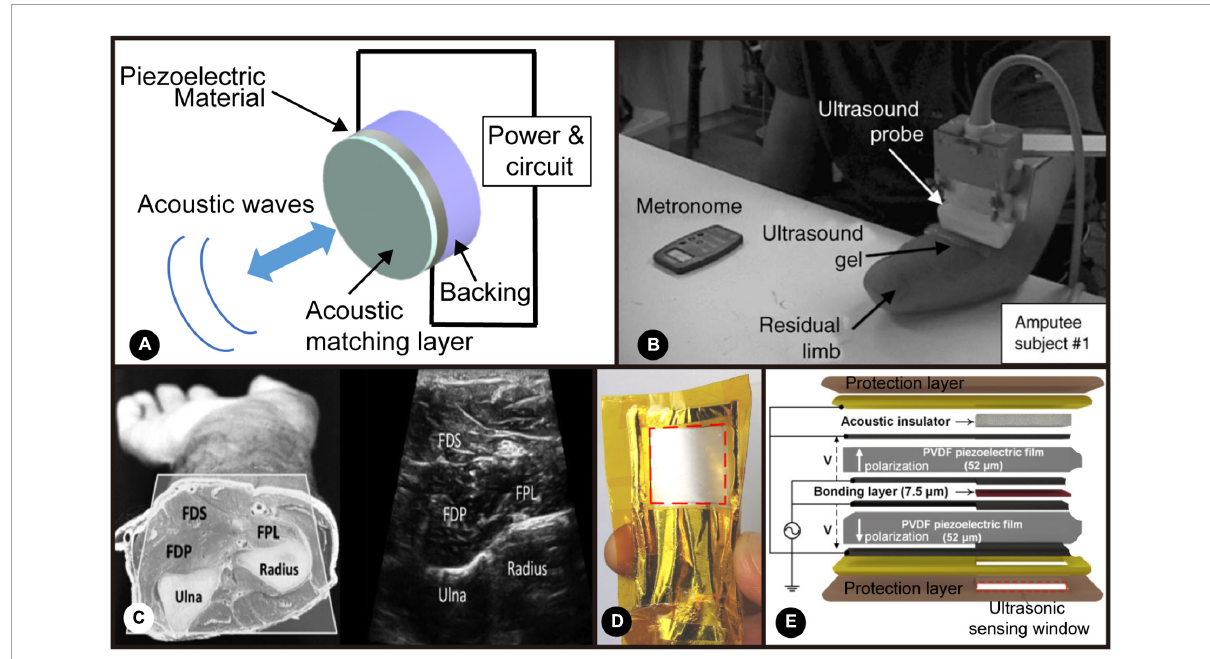
FIGURE6 (A) Schematic of an ultrasonic transducer. Adapted from Sanchez et al. (2021). Copyright 2021, IEEE; (B) Experimental set-up by Zheng et al. (2006). Reproduced with permission (Zheng et al., 2006). Copyright 2006, Elsevier; (C) the cross-section and ultrasound image of the forearm muscles by Akhlaghi et al. (2016). Adapted from Akhlaghi et al. (2016). Copyright 2016, IEEE; (D) the photo of wearable ultrasonic sensor developed by AlMohimeed and Ono (2020). Reproduced with permission (AlMohimeed and Ono, 2020). Copyright 2006, MDPI; (E) schematic of the flexible, single-element ultrasonic transducer by AlMohimeed and Ono (2020). Reproduced with permission (AlMohimeed and Ono, 2020). Copyright 2006,